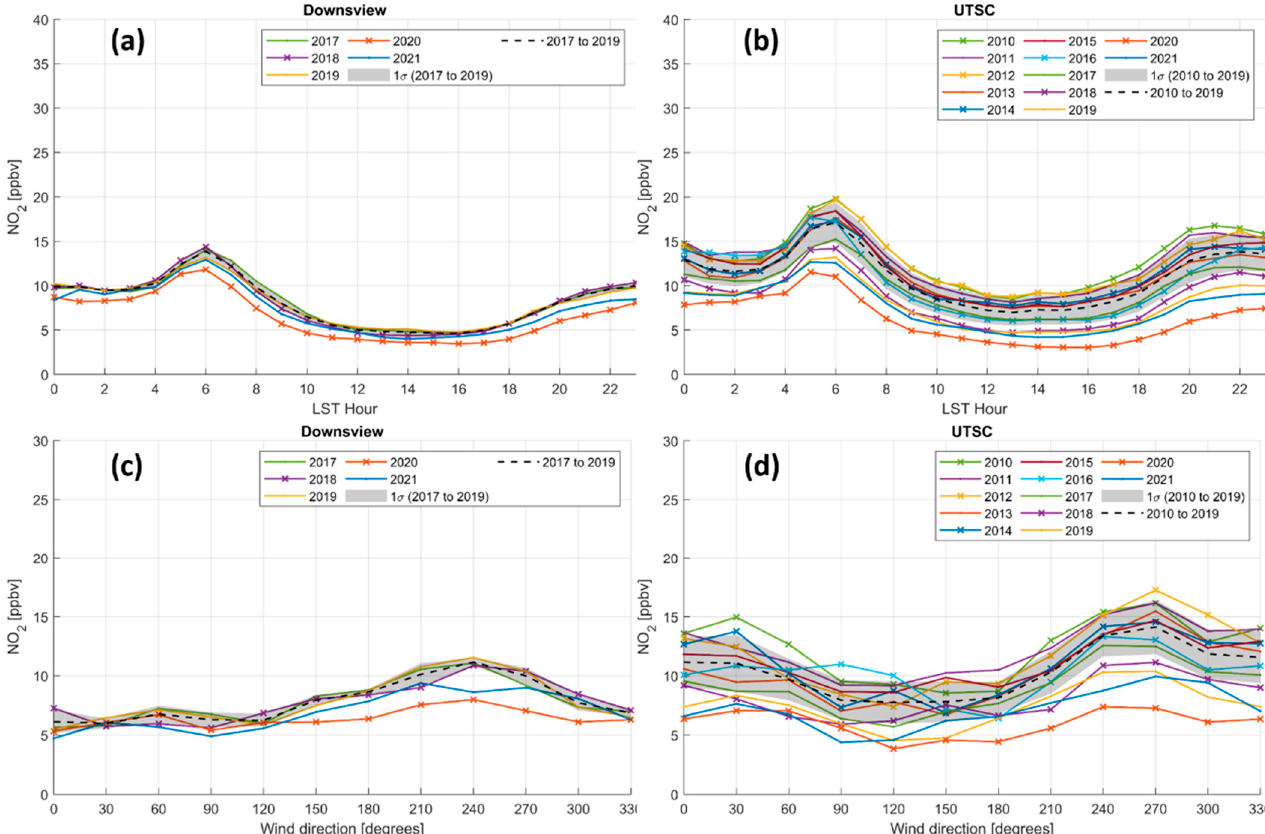
Figure 7. In situ measured NO 2 surface concentration at Downsview ( a , c ) and Toronto East ( b , d ) sites binned by local standard time (LST) in hours and wind directions (observations from 15 March to 15 September for each year). The black dashed line is the mean of observations from pre-pandemic with shading area representing the standard deviation of the mean.